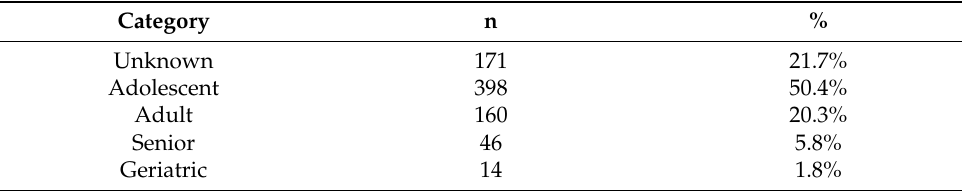
Table 1. Age profile of dogs (n = 789) examined for endoparasites.